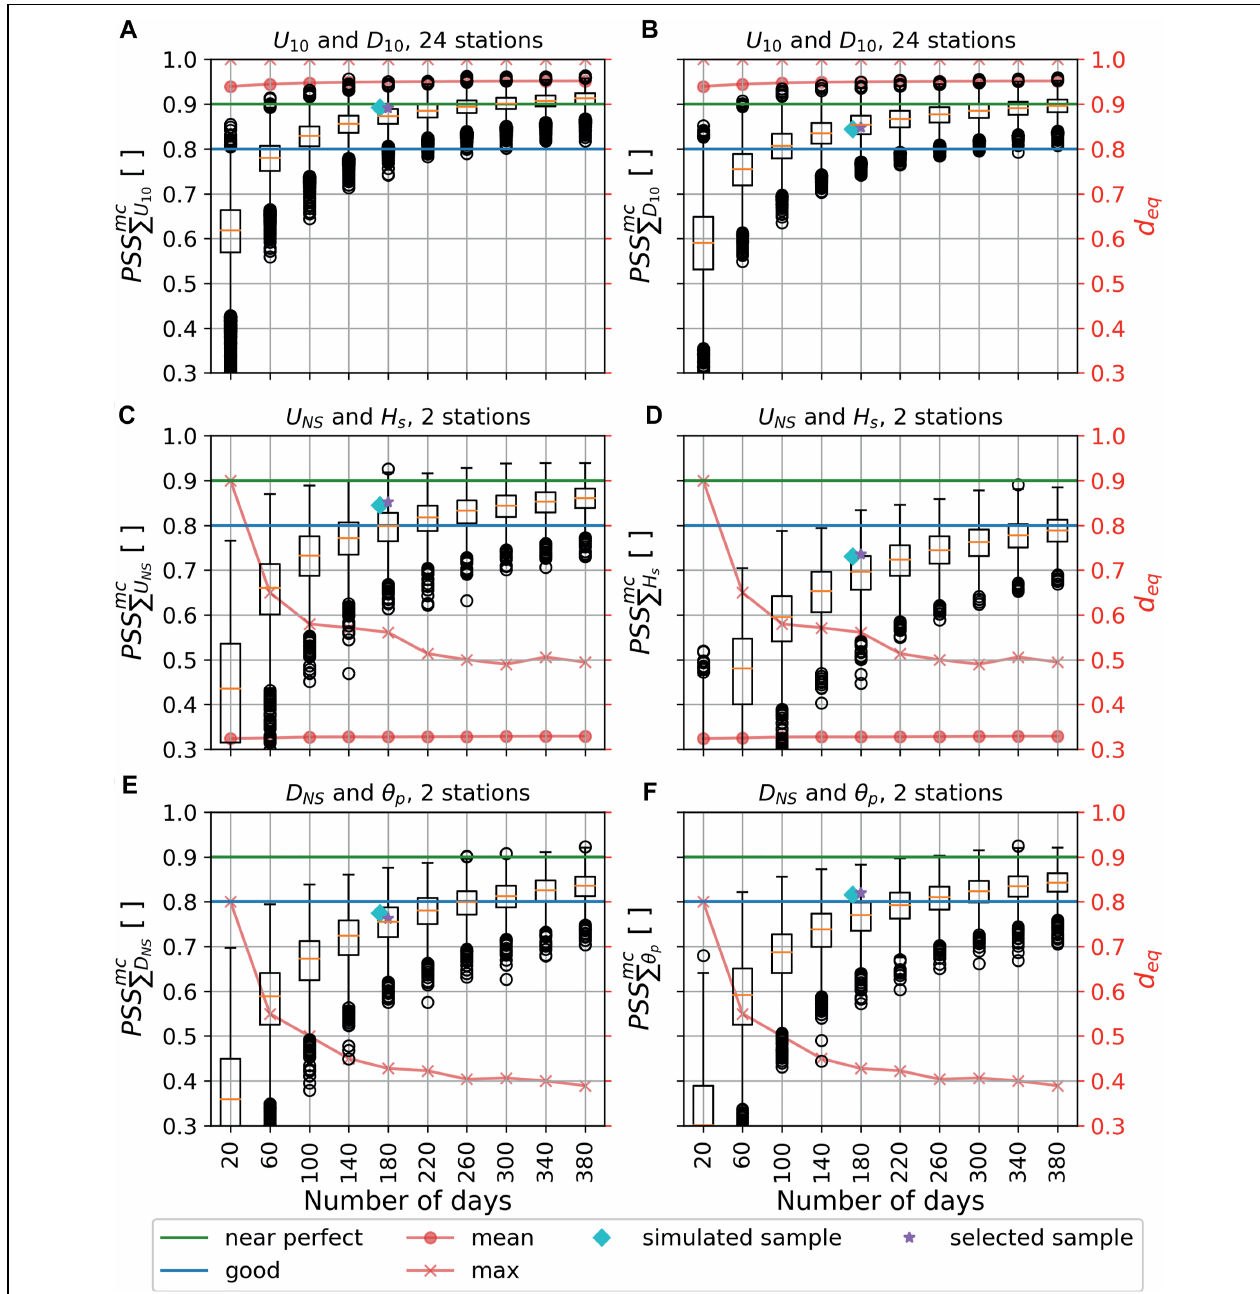
FIGURE 6 | Same as Figure 3 , but for (A,B) the projected two-dimensional distributions 10-m wind speed, U 10 , and direction, D 10 , (C,D) near-surface wind speed ( U NS ) and significant wave height ( H s ) , and (E,F) near-surface wind direction ( D NS ) and peak wave direction ( τ p